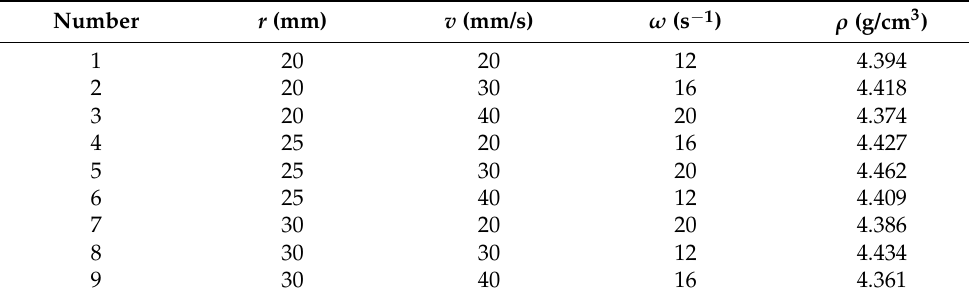
Table 7. Orthogonal test protocol and result data.